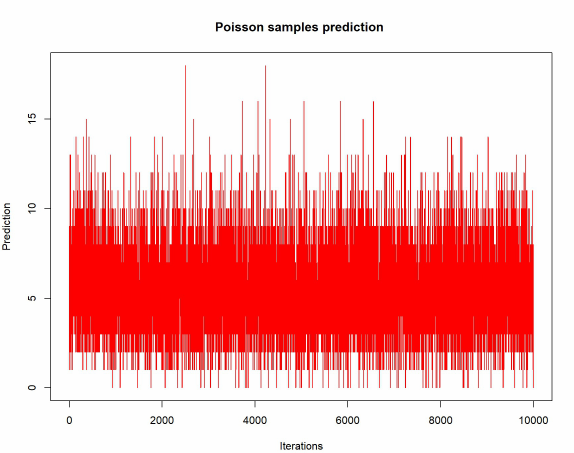
Figure 6. 10000 iterations trace plot of theta.